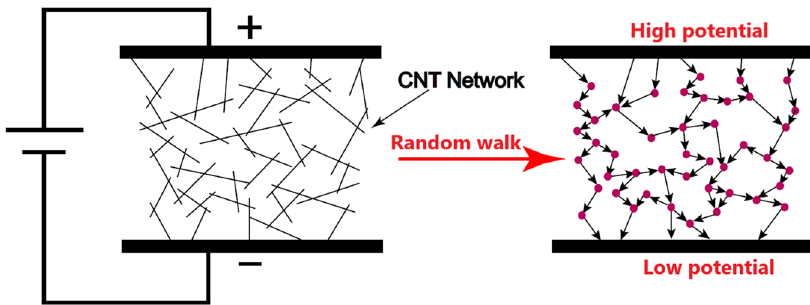
Figure 9: Random walk model for calculating the resistivity of CNT networks [ 11 ]